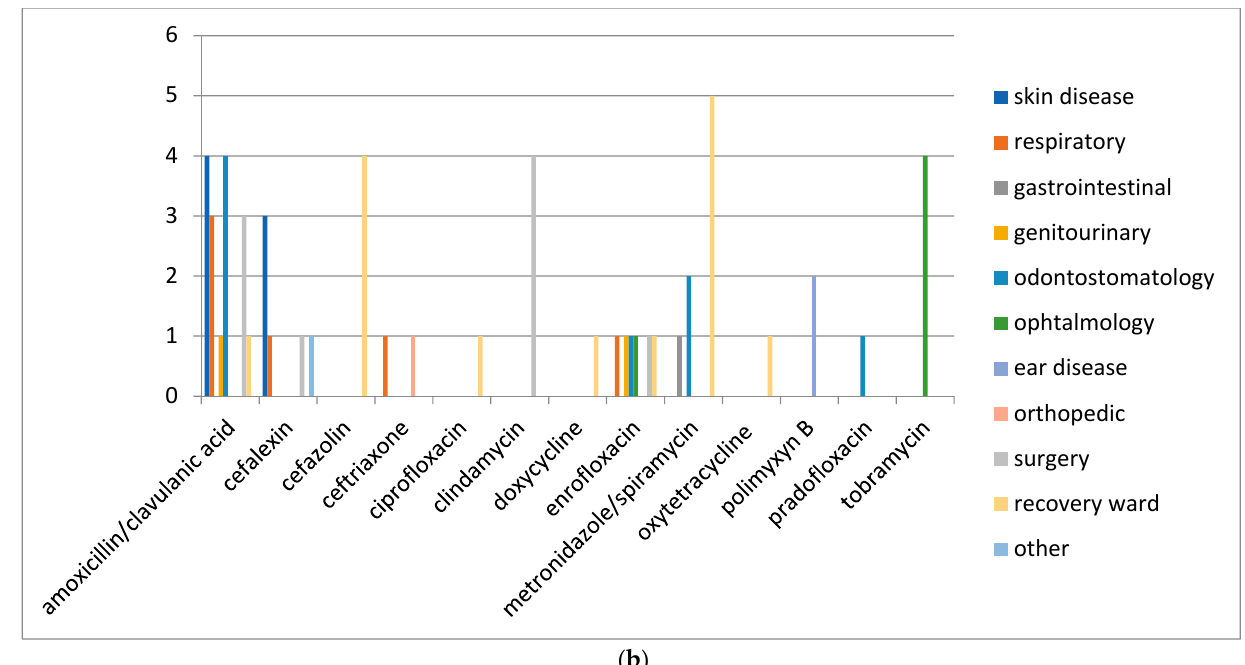
Figure 2. ( a ) Distribution of No. 422 antimicrobials treatments according to the organ/system in dogs before VEP. ( b ) Distribution of No. 56 antimicrobials treatments according to the organ/system in cats before VEP.